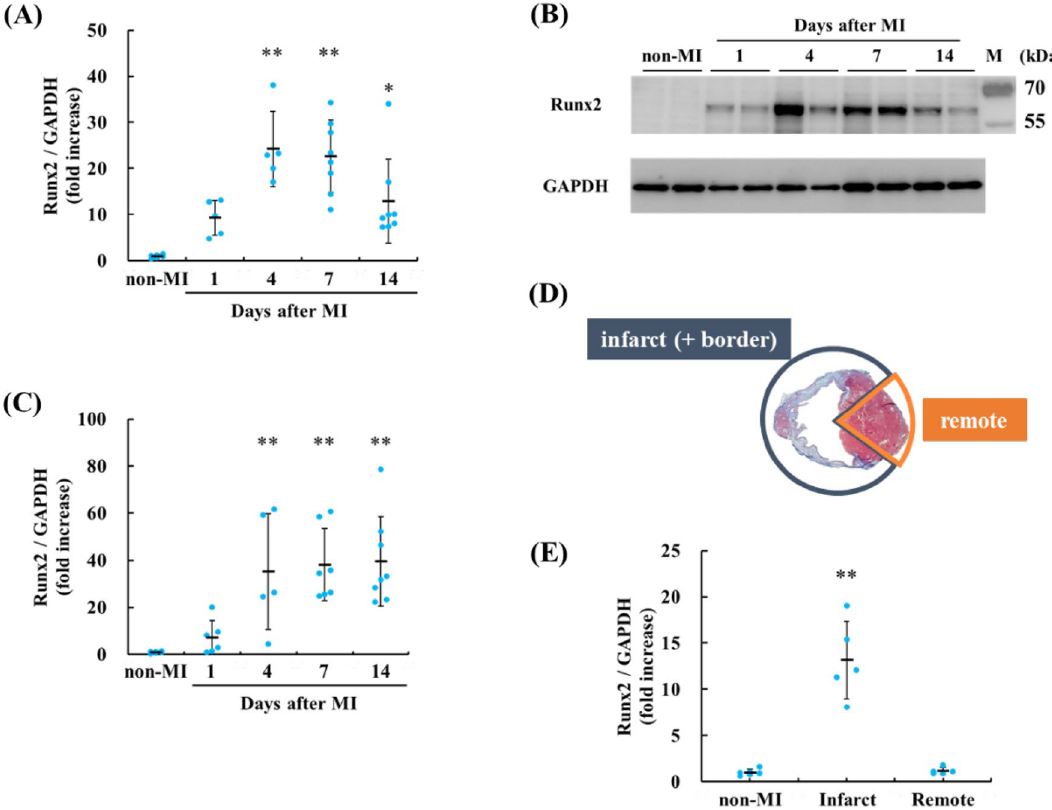
Figure 1. The expression of Runx2 was upregulated in the murine hearts after MI. ( A ) mRNA expression of Runx2 was analyzed at indicated time-points by quantitative RT-PCR. The results were normalized to that of GAPDH. Data are shown as mean ± SD (n = 5 mice for MI1d, 4d, n = 6 mice for non-MI, n = 8 mice for MI7d, 14d), * P < 0.05, ** P < 0.01 vs non-MI by Kruskal–Wallis test followed by Steel test. ( B ) The heart lysates from WT mice at 1, 4, 7, and 14 days after MI were immunoblotted with anti-Runx2 and anti-GAPDH antibodies. The heart lysates from non-MI mice were used as a control. Representative images are shown. ( C ) Runx2 expression was quantified. Data are shown as mean ± SD (n = 5 mice for MI4d, n = 6 mice for non-MI, MI1d, n = 7 mice for MI7d, n = 8 mice for MI14d), ** P < 0.01 vs non-MI by Kruskal–Wallis test followed by Steel test. ( D ) Masson’s trichrome staining was performed to identify the infarct (+ border) and the remote areas. Representative image is shown. ( E ) The mRNA expression of Runx2 was quantified 7 days after MI by quantitative RT-PCR. Data are shown as mean ± SD (n = 5 mice for MI7d, n = 6 mice for non-MI), ** P < 0.01 vs non-MI, remote area by Kruskal–Wallis test following by Steel–Dwass